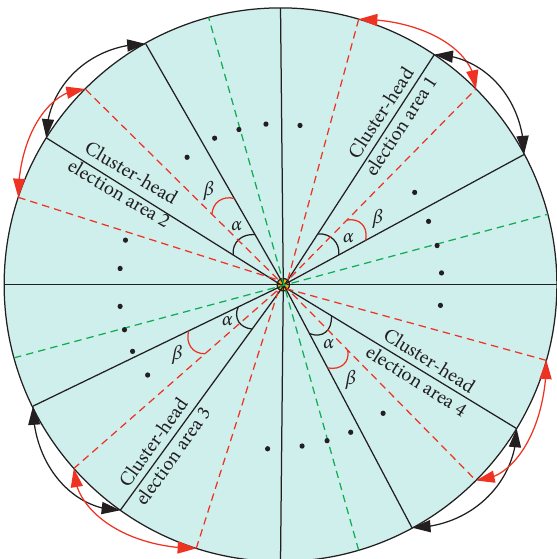
Figure 2: Rotation of CH election areas ( z � 4, β � 5 ° ).